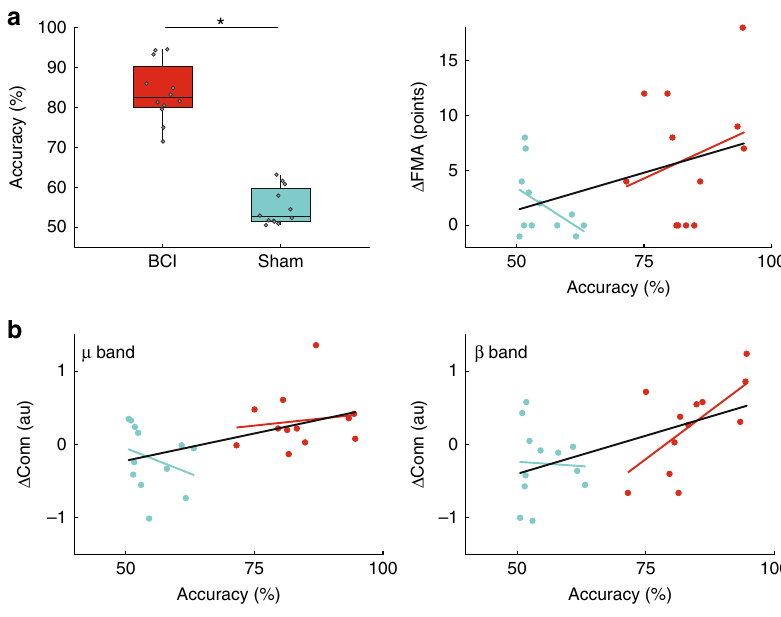
Fig. 4 Accuracy of contingency between last PSD sample classi fi cation and FES. a Left. Values for the BCI ( N = 14, red) and the sham ( N = 13, light blue) groups (two-tailed unpaired t -test, p < 10 − 10 ). Right. Accuracy vs Δ FMA score (post – pre intervention), together with the least-square fi t lines for both groups pooled (black line) and for each group separately (color lines). b Left. Accuracy vs Δ Connectivity in μ band (post – pre intervention), together with the least-square fi t lines for both groups pooled (black line, N = 24) and for each group separately (color lines). Right. Accuracy vs Δ Connectivity in β band (post – pre intervention), together with the least-square fi t lines for both groups pooled (black line). Correlations between these metrics were signi fi cant (Pearson ’ s correlation, μ : r = 0.49, p = 0.02; β : r = 0.55, p = 0.005). Fits for each group separately are shown for representation purposes (colored lines; N = 12 for BCI and sham